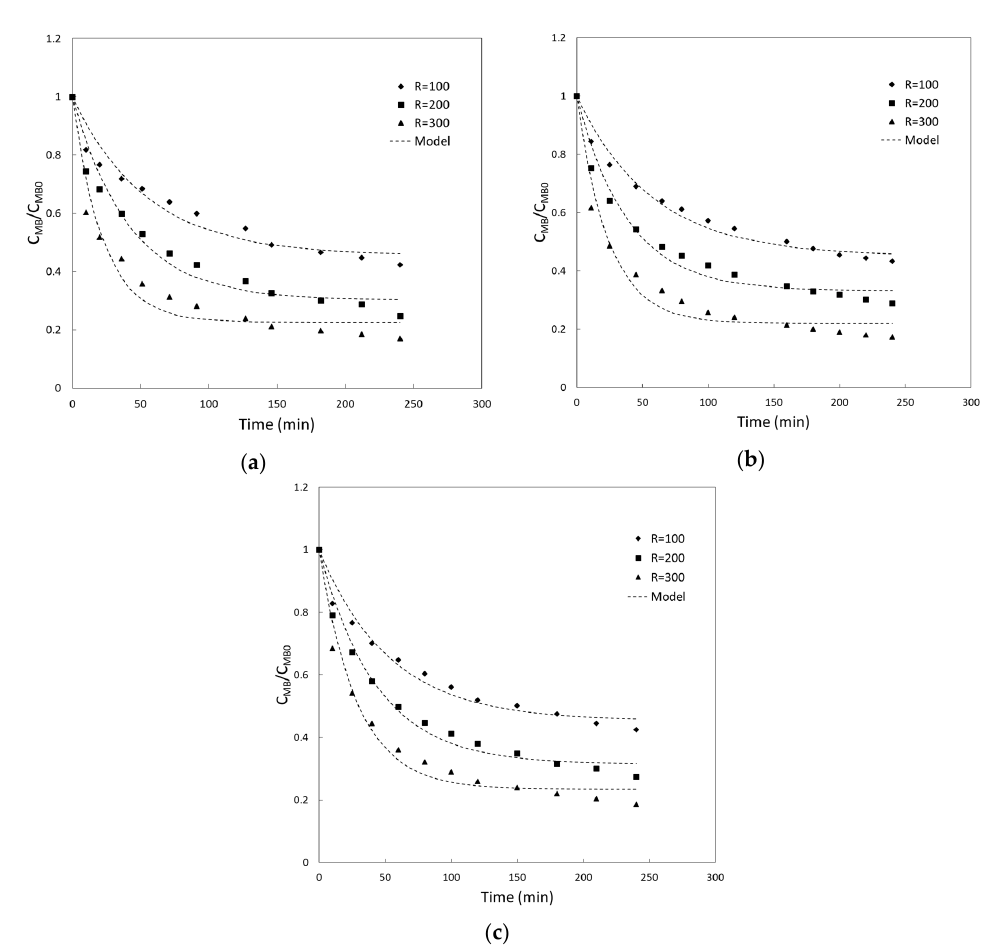
Figure 6. MB adsorption in yerba mate at different R values (100, 200, 300 for each graph) and at temperatures of 283 K ( a ), 293 K ( b ) and 313 K ( c ).